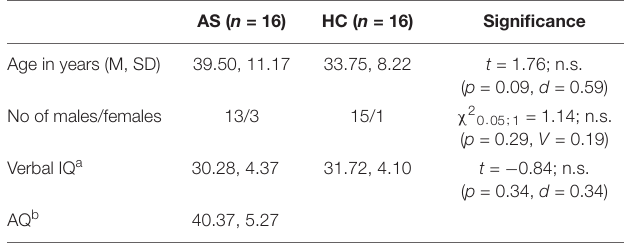
TABLE 1 | Characteristics of the experimental